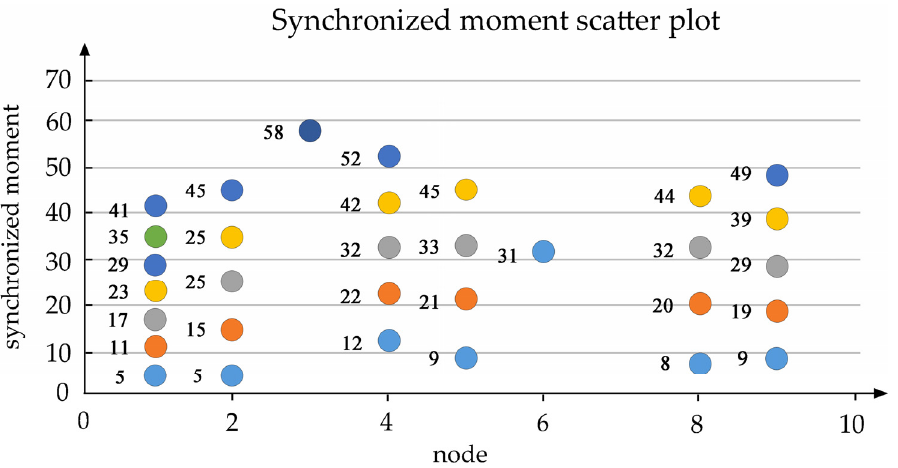
Figure 5. Jiangyin synchronized moment scatter plot. Based on the same calculation process, departure timetables of the transit network in Sihui and Qian’an are shown in Tables 7 and 8, respectively. Table 7. Departure timetable for Sihui. Line Level Line Number Departure Time